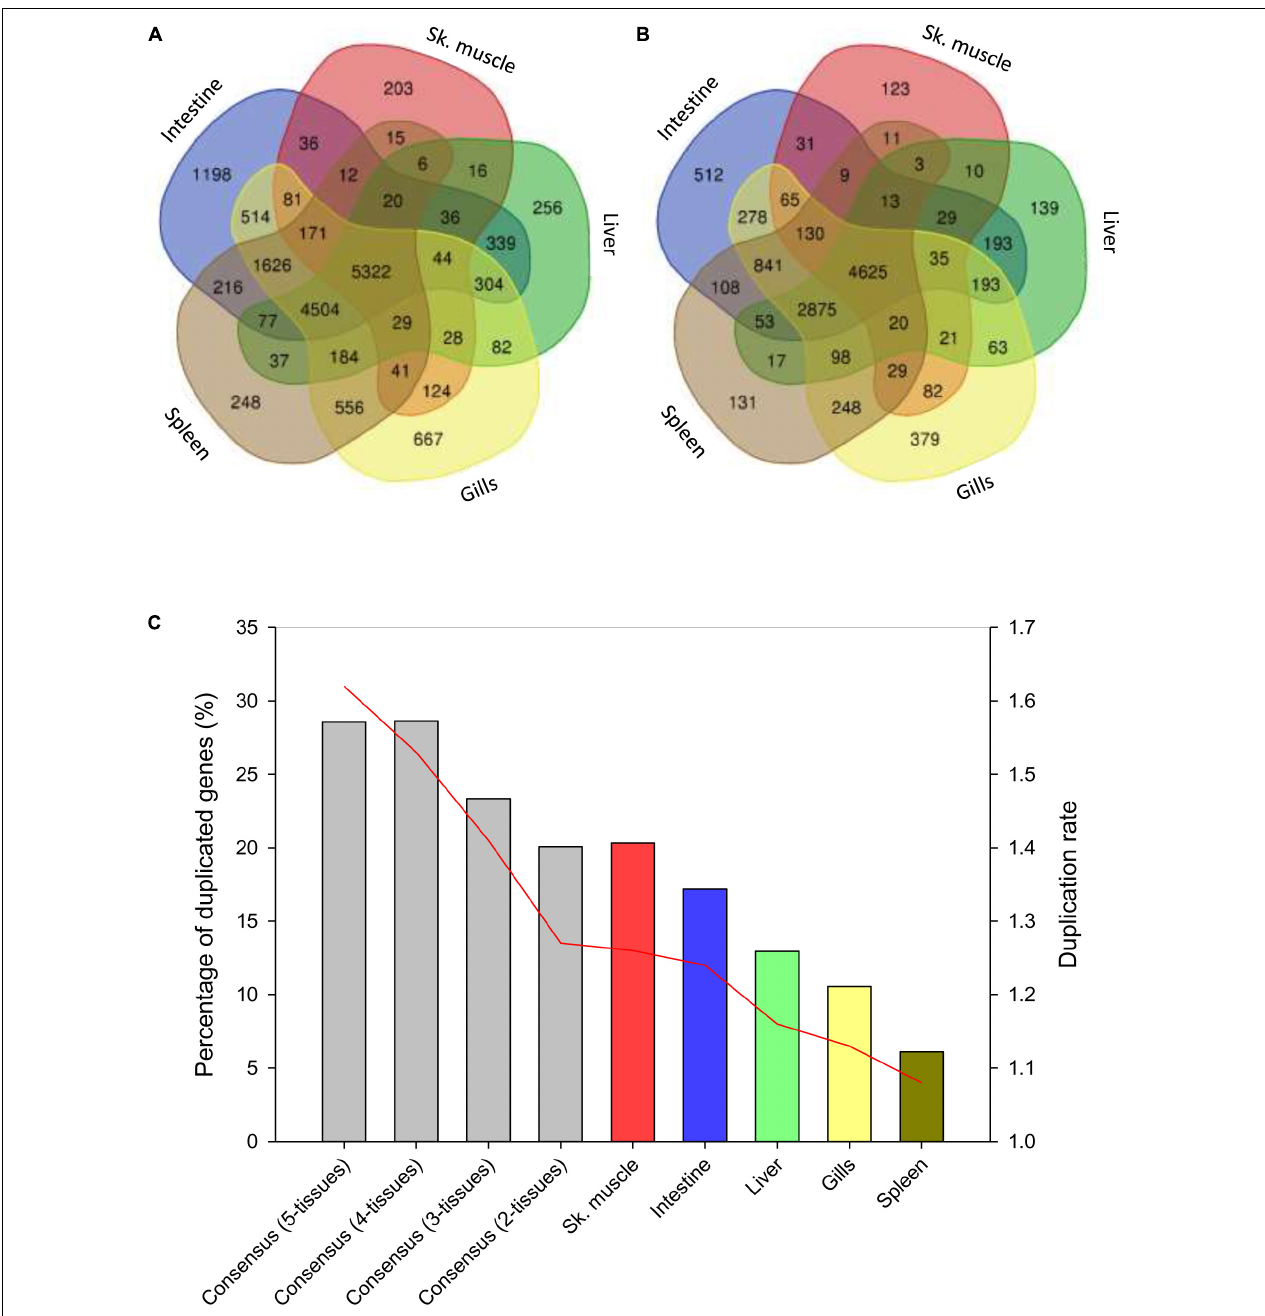
FIGURE 5 | Tissue expression signatures. (A) Venn diagram showing the overlap between the gene expression signatures in all analyzed tissues. (B) Venn diagram showing the overlap between unique gene annotation expression signatures in all analyzed tissues. Homology-based annotation was done according to the gilthead sea bream transcriptome (Pauletto et al., 2018) and NCBI non-redundant (Nr) database. (C) Percentage of duplicated genes among tissues or groups of tissues (blue columns). Red line represents the duplication rate of the unique gene annotations present in a tissue or in a group of tissues.